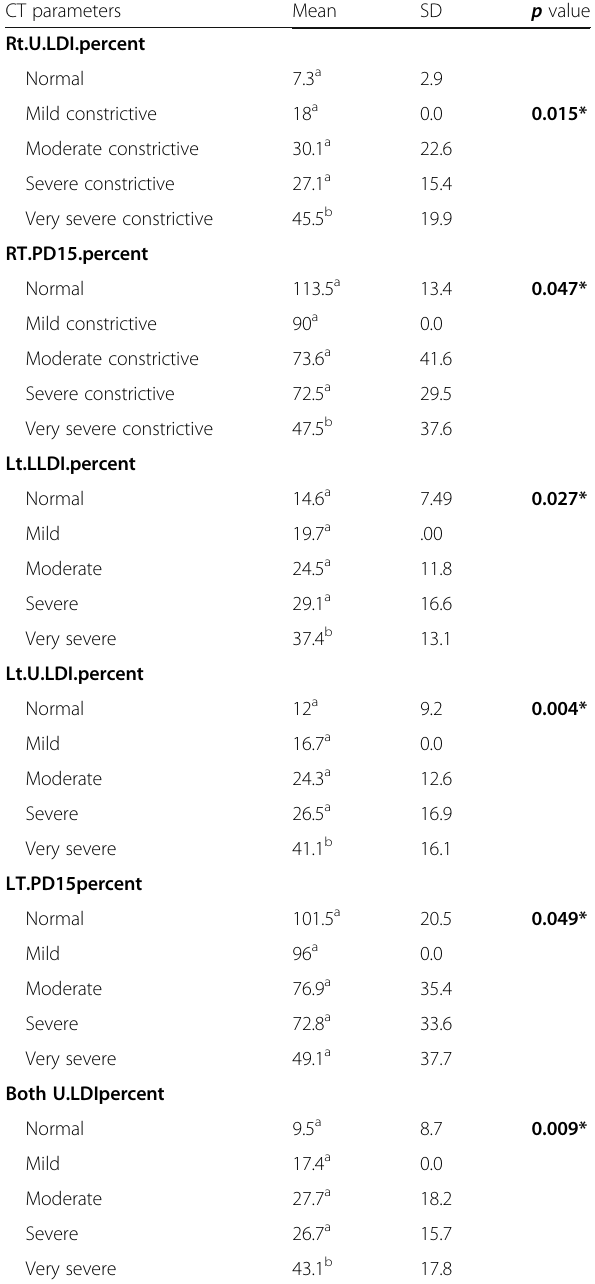
Table 2 Statistical comparison between different groups regarding significant lung parameters of multi-detector CT by ANOVA test CT